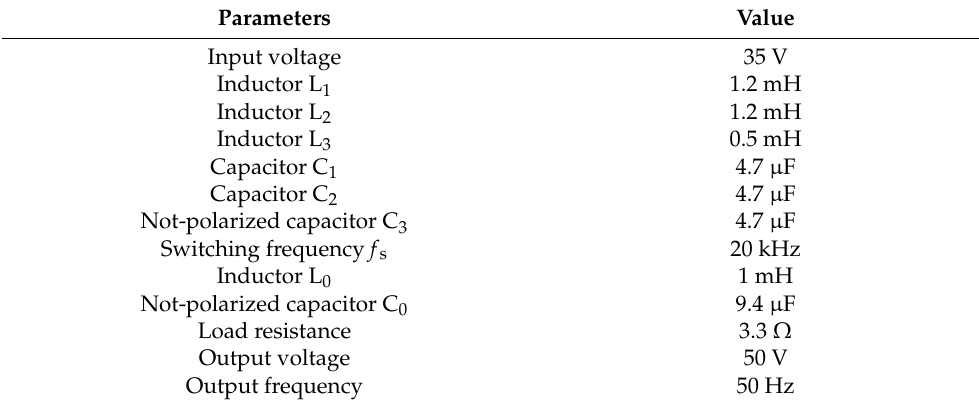
Table 1. Experimental